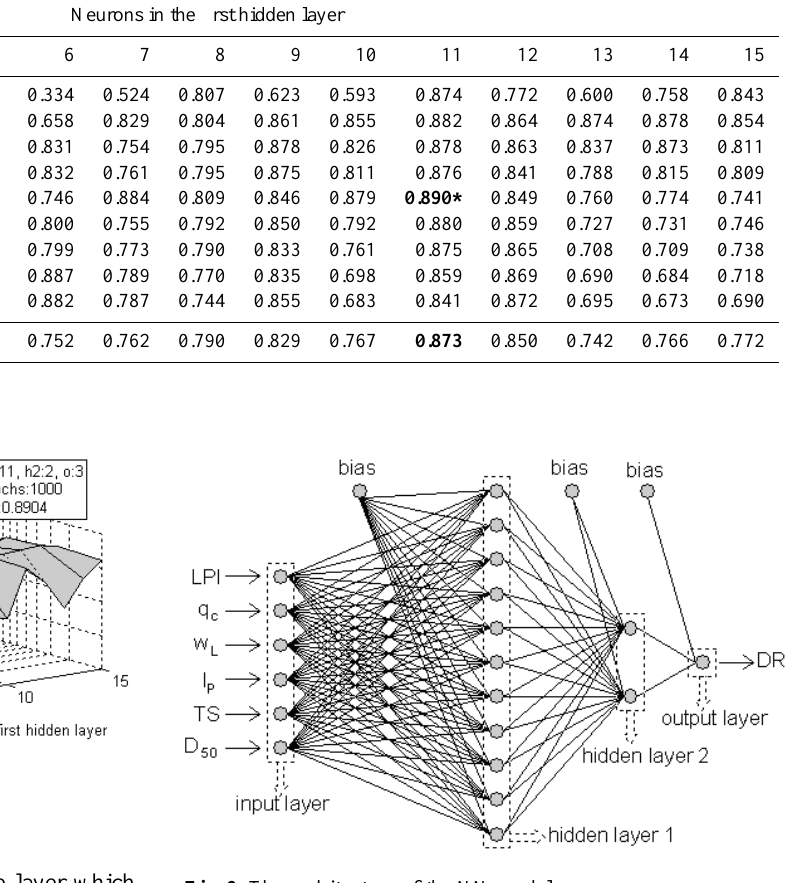
Fig. 9. The architecture of the NN model.